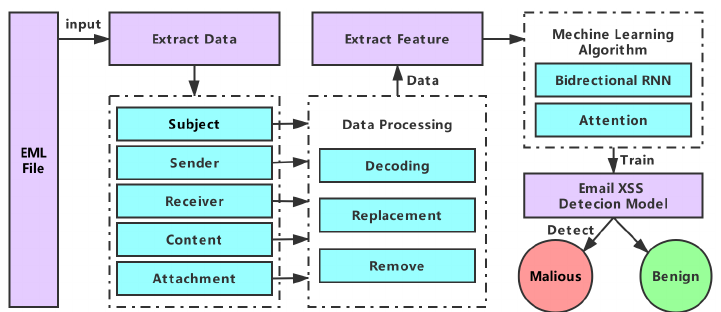
Figure 2. Webmail XSS detection